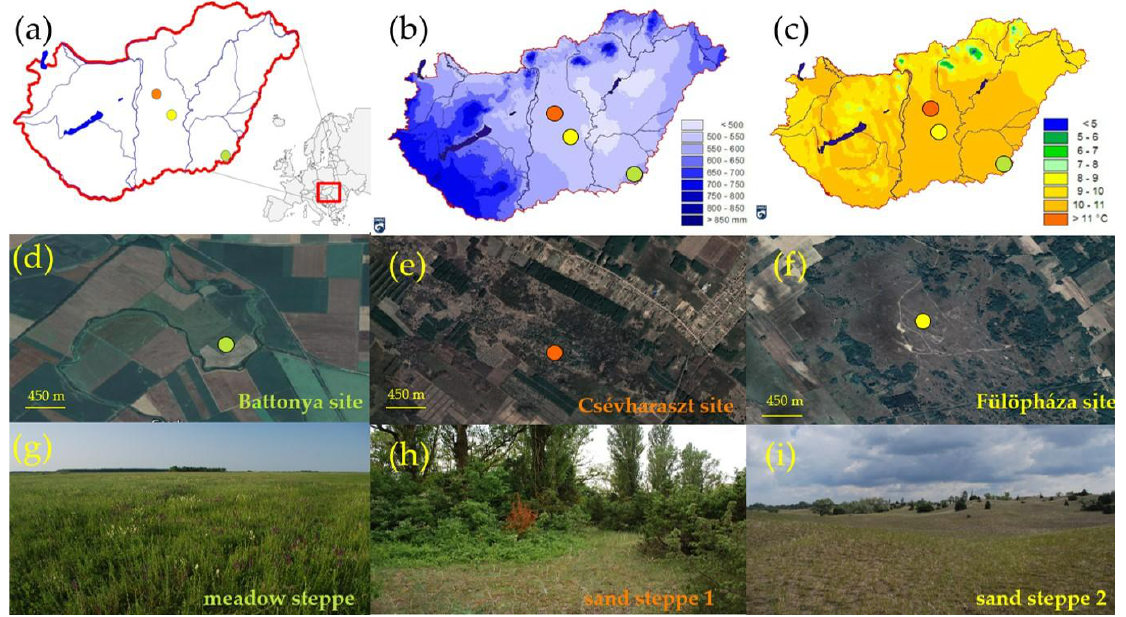
Figure 1. Location of the study sites at ca. 1:250 k spatial scale within Hungary ( a – c ), within the landscape matrix at ca. 1:10 k viewed from Google Earth ( d – f ) and at local sites at ca. 1:5 scale ( g – i ). Modeled long-term precipitation ( b , c ) mean annual temperature surfaces were sourced from https://www.met.hu/en/eghajlat/magyarorszag_eghajlata (accessed on 21 October 2021). The sites have similar warm temperate climates, with a sub-Mediterranean